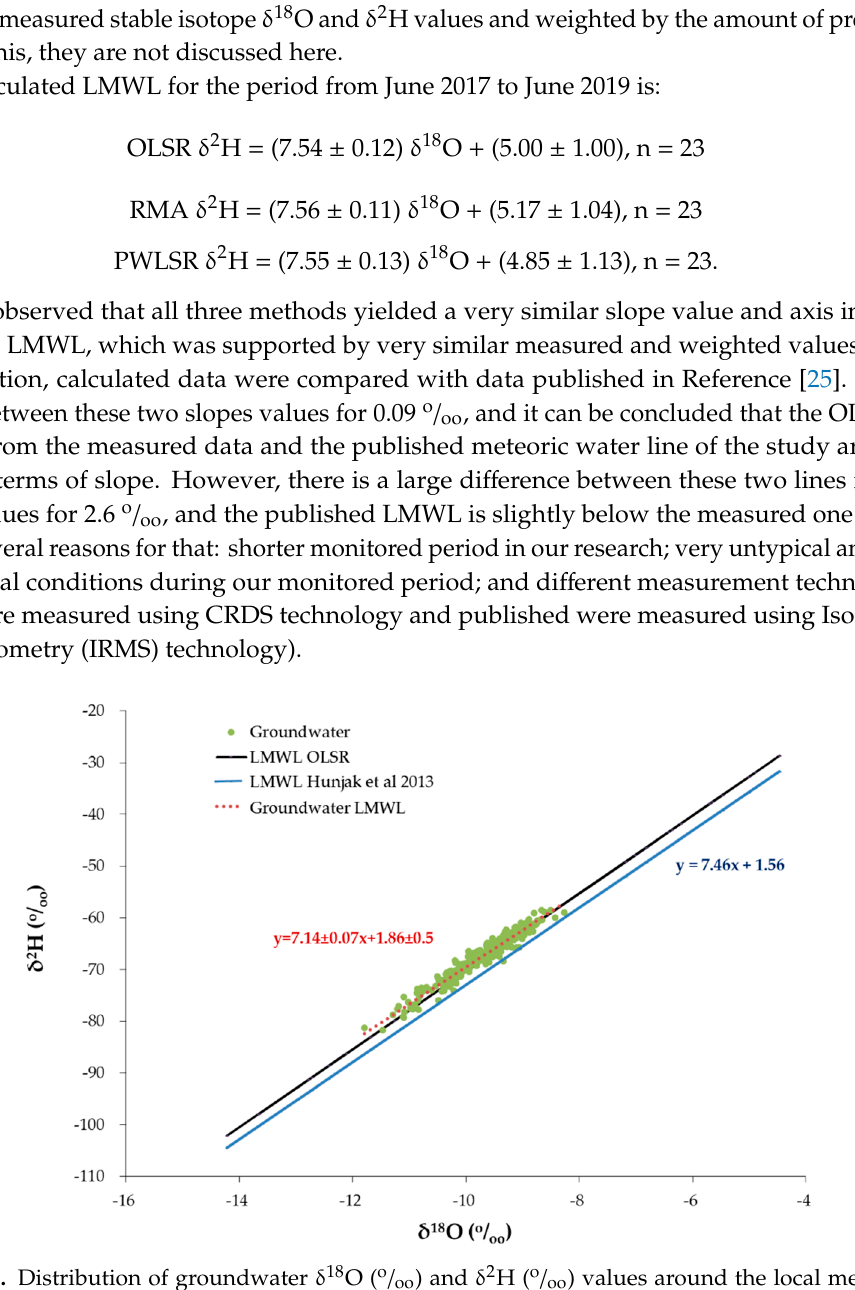
Table 7. Minimum, maximum, and averaged isotopic composition of the groundwater by sampled well.